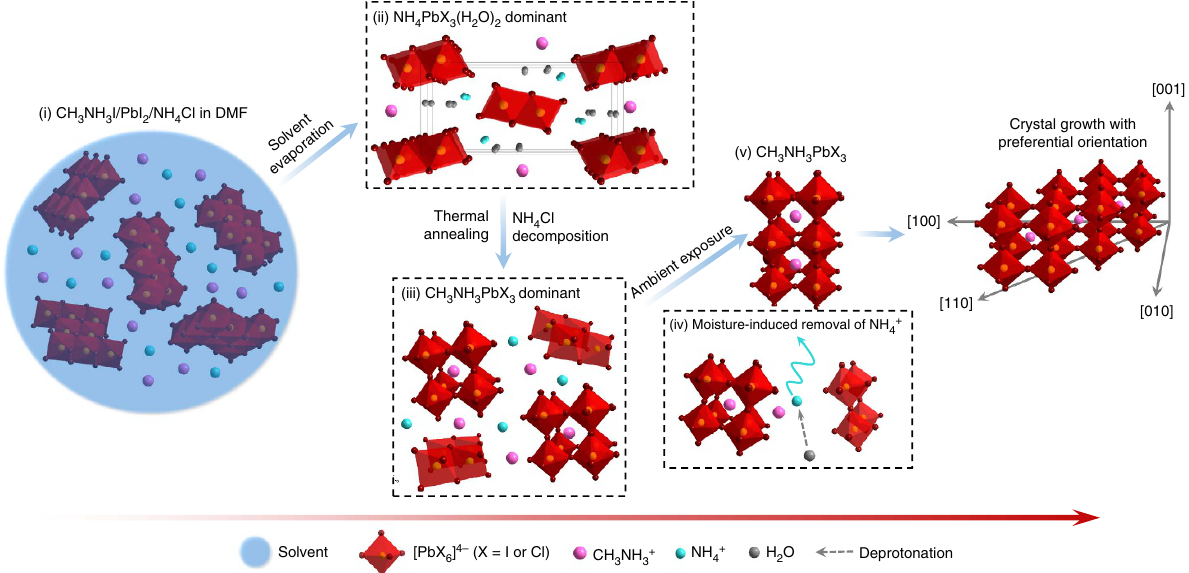
Figure 4 | Schematic view of the crystal growth process of perovskite CH 3 NH 3 PbX 3 in the presence of ammonium and moisture. (i) CH 3 NH 3 I, PbI 2 and NH 4 Cl dissolved in DMF. (ii) As the solvent evaporated, NH 4 þ and PbX 3 (cid:3) formed dominantly an ammonium lead trihalide dehydrate of NH 4 PbX 3 (H 2 O) x . (iii) During thermal annealing, NH 4 PbX 3 (H 2 O) x released NH 3 and combined with CH 3 NH 3 þ , partially transforming to perovskite CH 3 NH 3 PbX 3 . (iv) Moisture induced the removal of NH 4 þ and facilitated the (v) crystallization of CH 3 NH 3 PbX 3 . At the final stage, CH 3 NH 3 PbX 3 crystals grew along the [110]